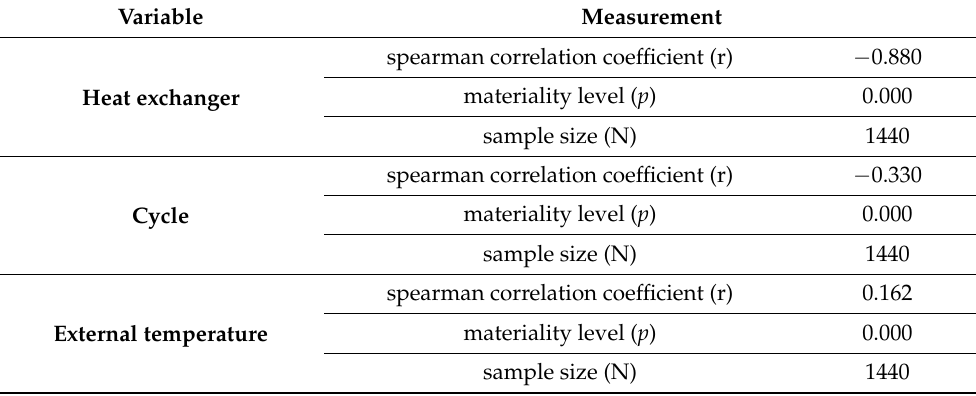
Table 8. Spearman correlation.